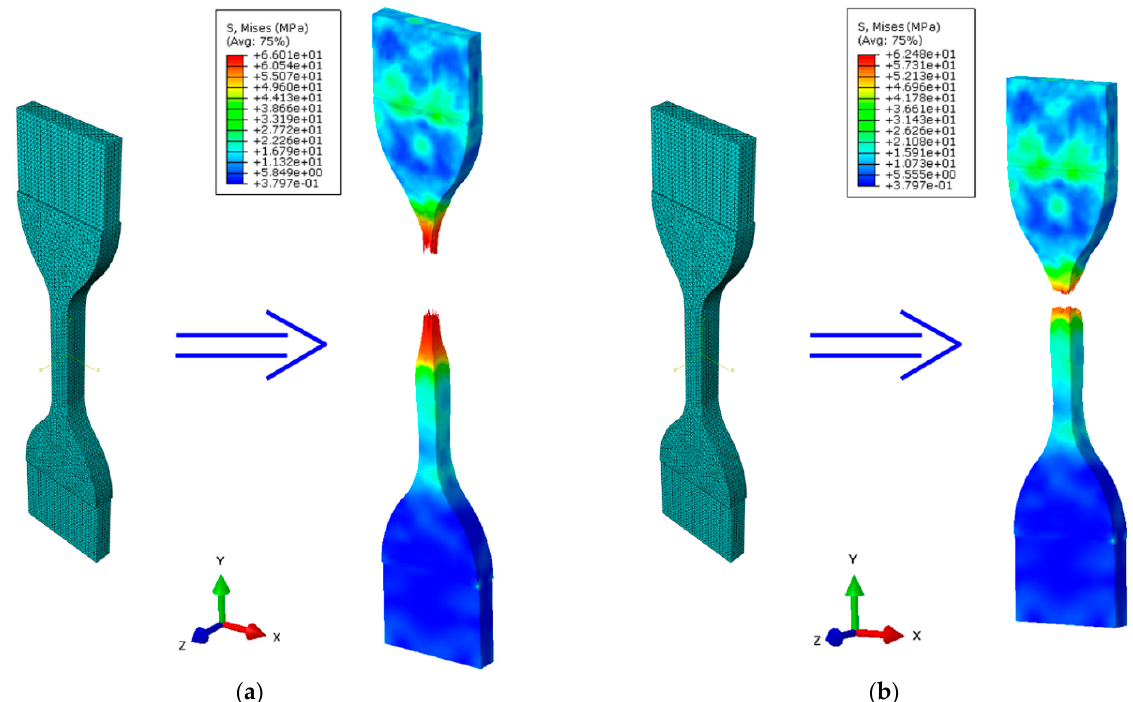
Figure 9. Selected numerical results from the tensile test of samples: ( a ) stress–von Mises distribution in PPS samples; ( b ) stress–von Mises distribution in PPM samples.